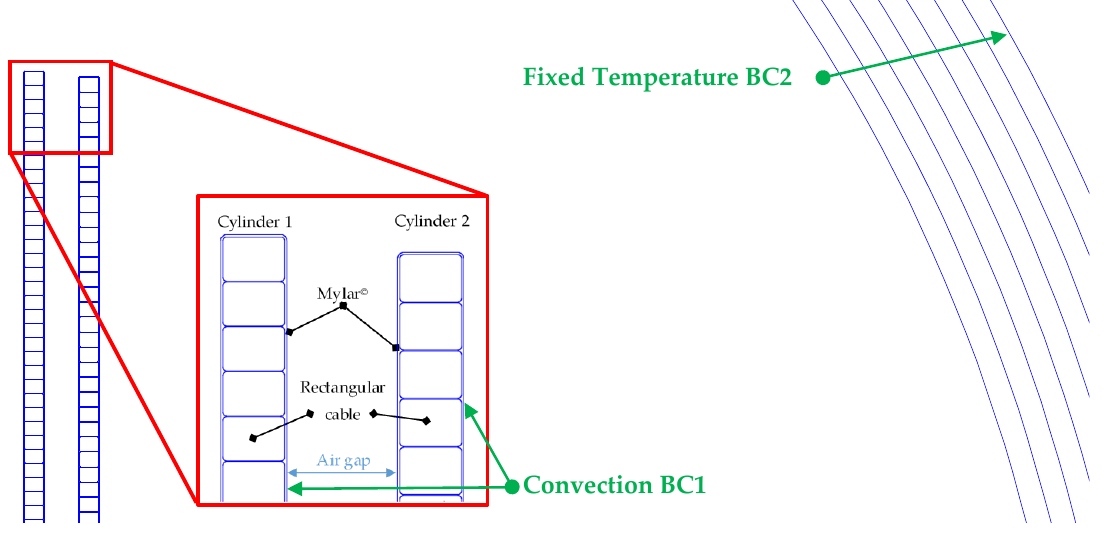
Figure 12. Definition of boundary conditions.